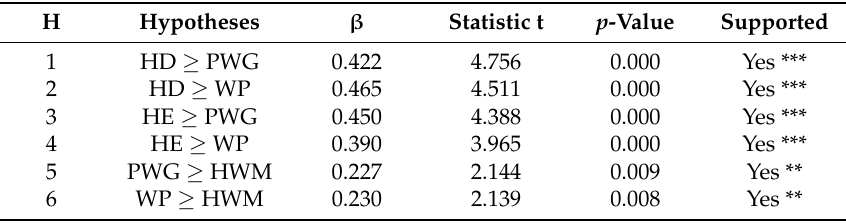
Table 5. Coefficients path and statistical significance.